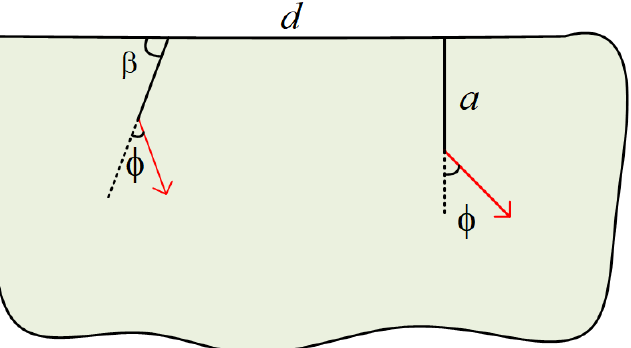
Figure 18. Schematic diagram of two edges of crack forms ( β is the crack inclination angle, φ is the crack propagation angle, d is the crack spacing, L is the crack length, and the red arrow is the direction of the propagation crack).